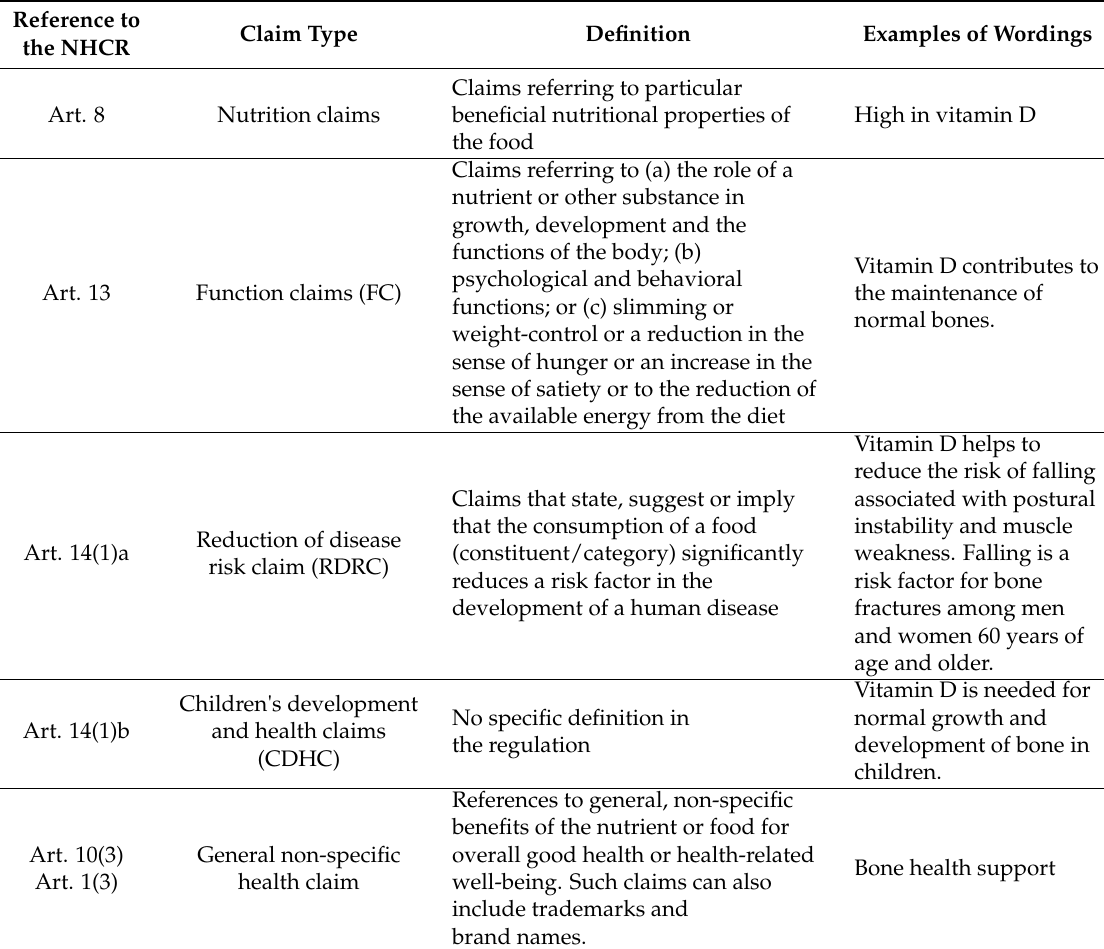
Table 1. Categorization of nutrition and health claims in the European Union according to the